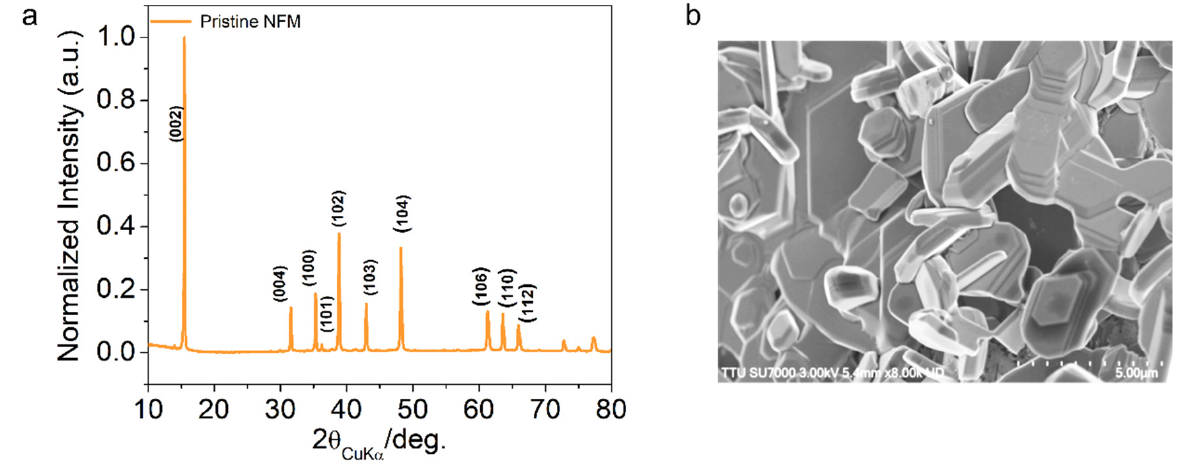
Figure 3. ( a ) X-ray Diffraction (XRD) patterns for Na 0.66 Fe 0.5 Mn 0.5 O 2 (NFM) and corresponding hkl values. ( b ) The Scanning electron microscopy (SEM) image of NFM.